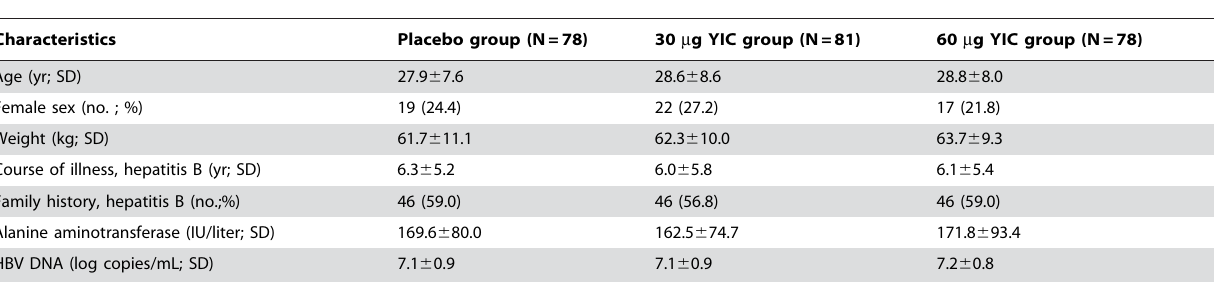
injection (1 in placebo group, 1 in 30 m g YIC group), one occurred after 5 injections (in 30 m g YIC group), and the other four appeared after 6 injections (1 in placebo group, 1 in 30 m g YIC